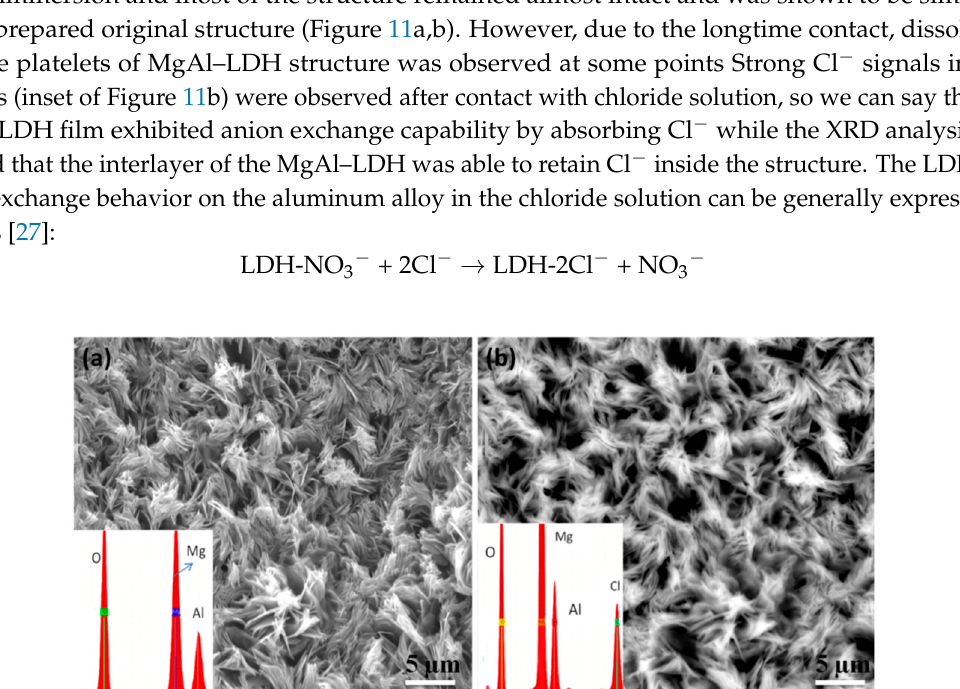
Figure 11. SEM images of ( a ) original MgAl LDH coating, 60 °C–24 h sample and ( b ) an immersed sample soaked in 0.1 M NaCl solution for 7 days (Insets are the corresponding EDS spectra).